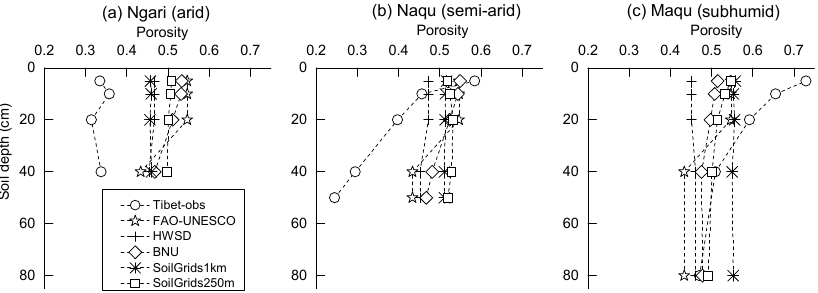
Figure 12. Comparisons between the porosity estimated from various existing datasets based on BD scheme and the in situ measurements.